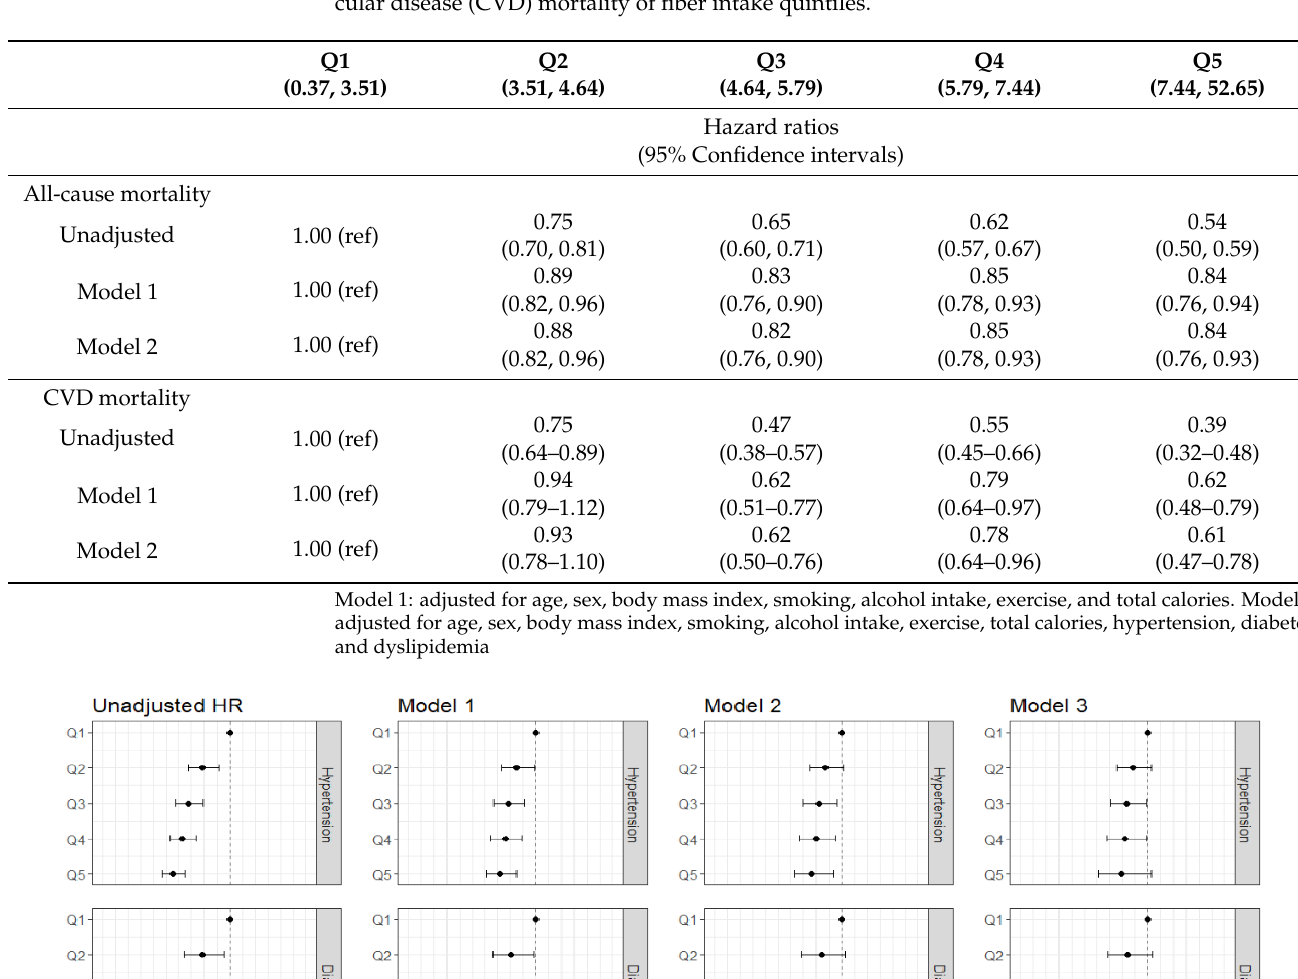
Table 3. Multiple Cox proportional hazard regression analysis for all-cause mortality and cardiovas- cular disease (CVD) mortality of fiber intake quintiles.